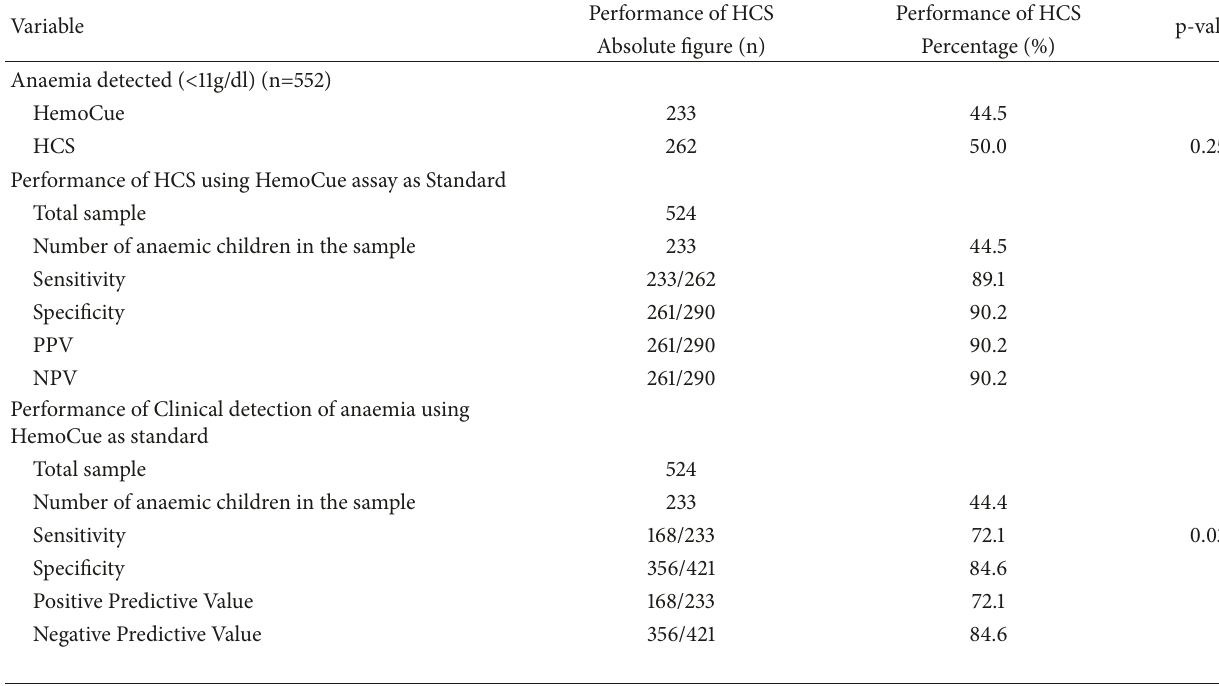
Table 1: The performance of HCS in estimating haemoglobin using HemoCue assay as standard.